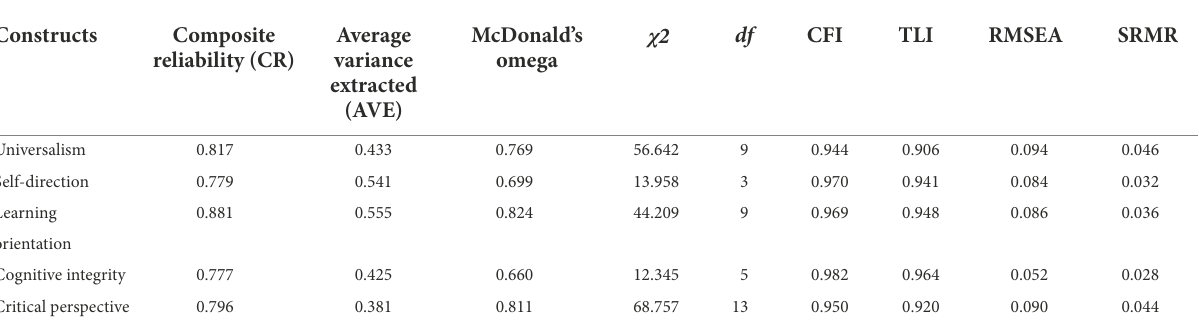
TABLE 3 Psychometric properties of the